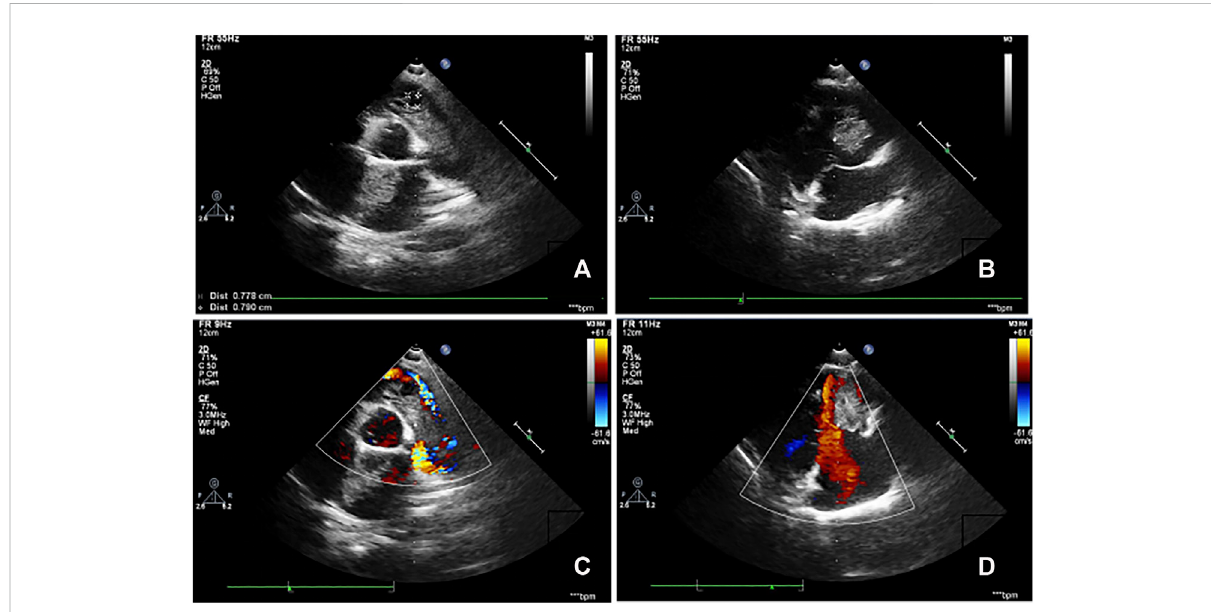
FIGURE 3 Echocardiography images of the proband. (A,B) . Clumpy echogenic mass in the left atrium and right ventricle. (C,D) . No obvious enhancement was observed on the enhanced scan.